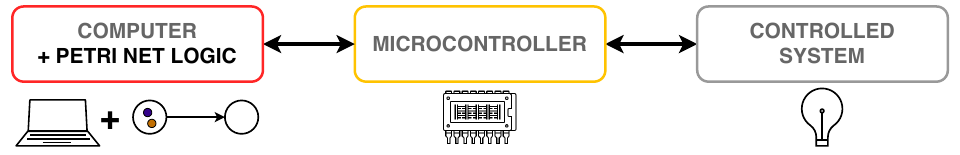
Figure 2. Basic scheme of proposed solution—Petri net’s logic in PC [26].